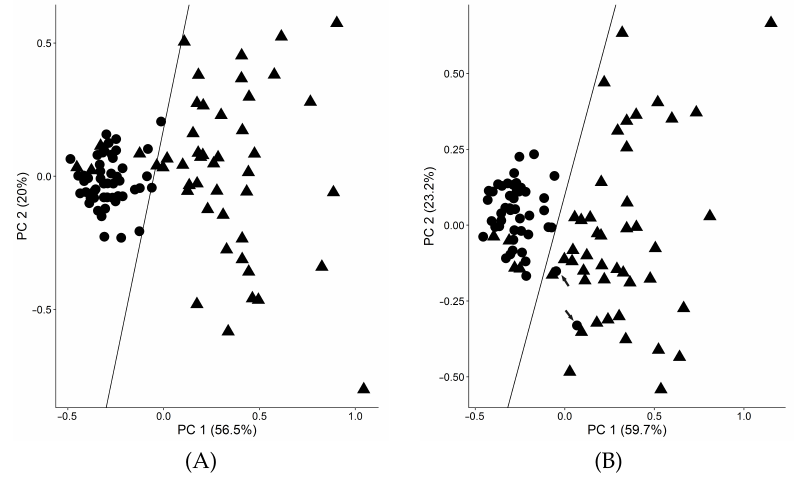
Figure 2. Principle component plots (PCP) of 48 T2DM patients (triangle) and non-diabetic controls (circle) using HbA 1C , fasting plasma glucose (FPG), free fatty acids (FAA), C-peptide levels, HOMA-IR, and fasting plasma insulin (FPI) as diagnostic parameters with glycated peptide 26 ( A ) or without glycated peptide 26 ( B ) as seventh diagnostic parameter. False positives ( B ) are indicated by arrows reducing the SP from 96% to 92%. PC1 and PC2 denote first and second principle components,